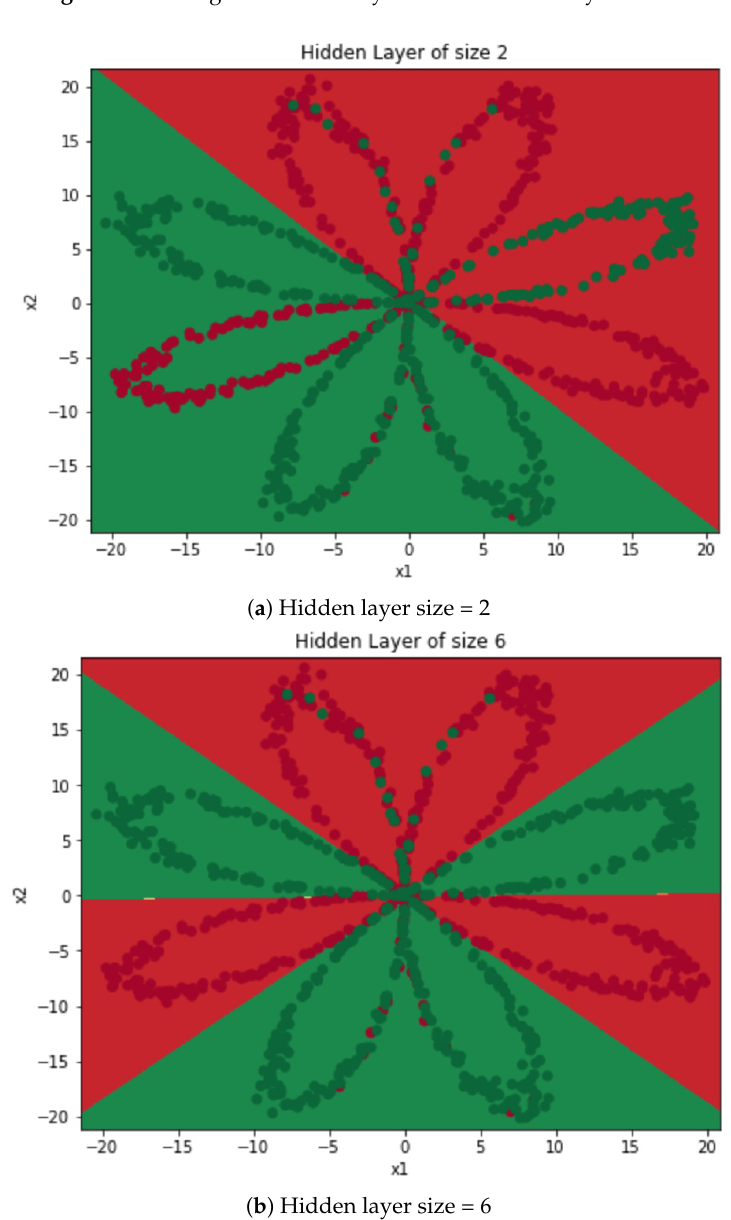
Figure 8. Decision boundary over different hidden layer sizes of the DTBNN